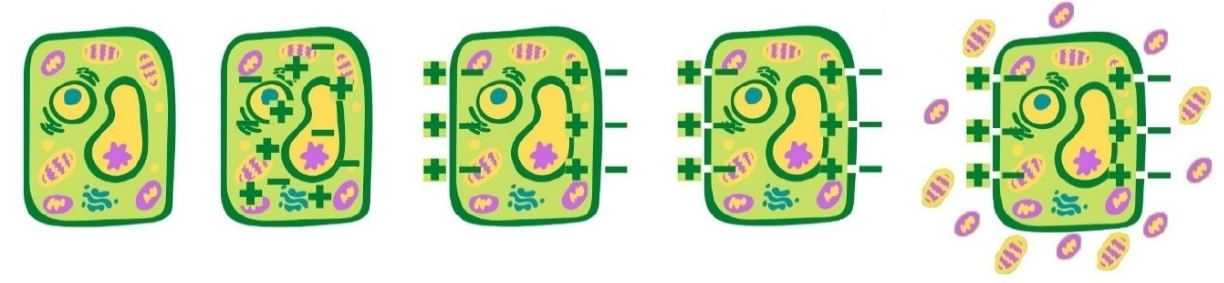
Figure 6. Mechanism of cell disintegration induced by PEF: electroporation phenomenon.